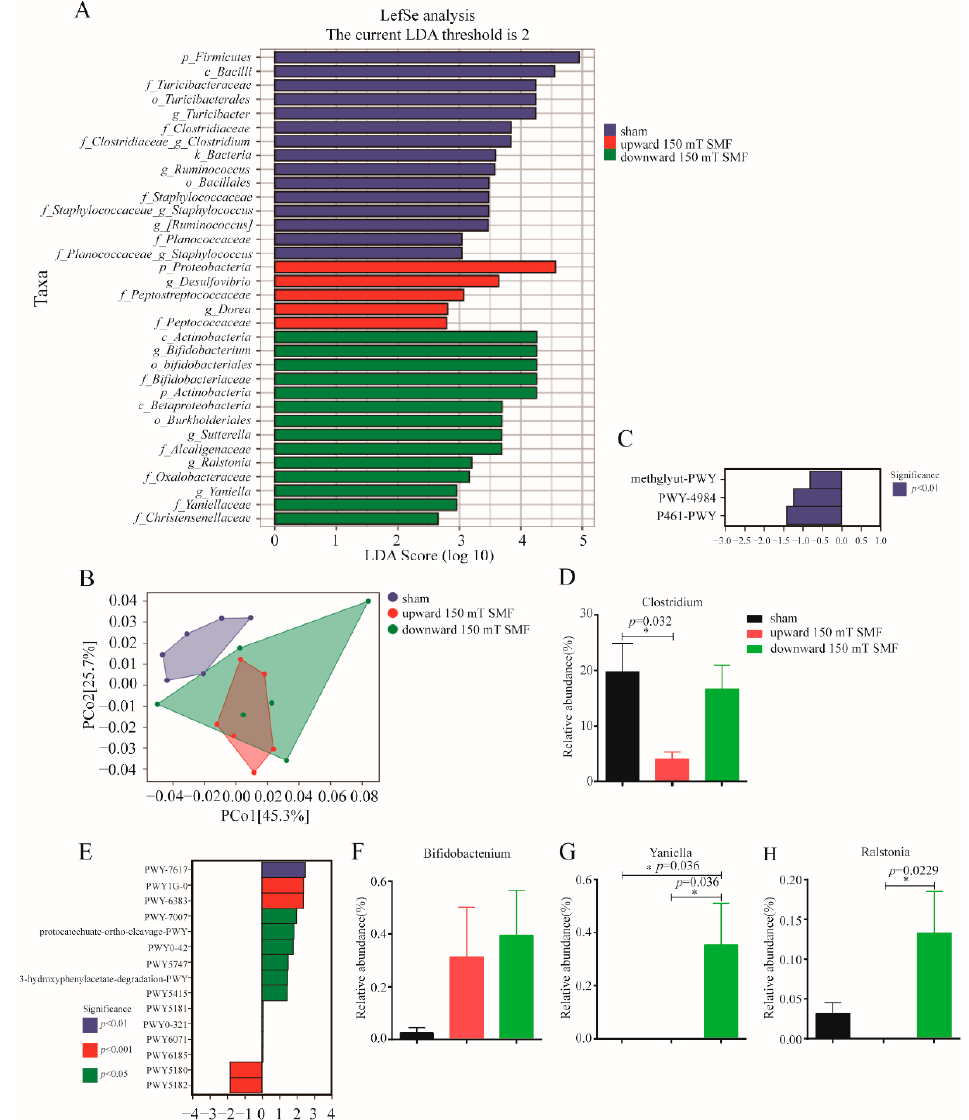
Figure 7. Long-term 150 mT SMFs exposure regulated metabolism function in adult female mice. ( A ) Histogram generated from LEfSe analysis exhibits differential microbes’ population in magnetic field treatment. Taxa enriched in microbiota from the Sham (blue), upward 150 mT SMF (red) or downward 150 mT SMF (green) groups were indicated with a positive LDA score, respectively (taxa with LDA score = 2 and significance of α < 0.05 determined by Wilcoxon signed- rank test). ( B ) PCoA analysis. ( C ) Metabolic pathway differences analysis between the upward 150 mT SMF and sham groups in adult female mice including methglyut-PWY, PWY-4984 and P461-PWY. ( D ) The relative abundance of genus Clostridium in PWY-4984. ( E ) Metabolic pathway differences analysis between the downward 150 mT SMF and sham groups in adult female mice. ( F – H ) The relative abundance of genus g_Bifidobacterium abundance in PWY1G-0, g_Ralstonia and g_Yaniella abundance in protocatechuate-ortho-cleavage-PWY and PWY-5180. “*” means p < 0.05.